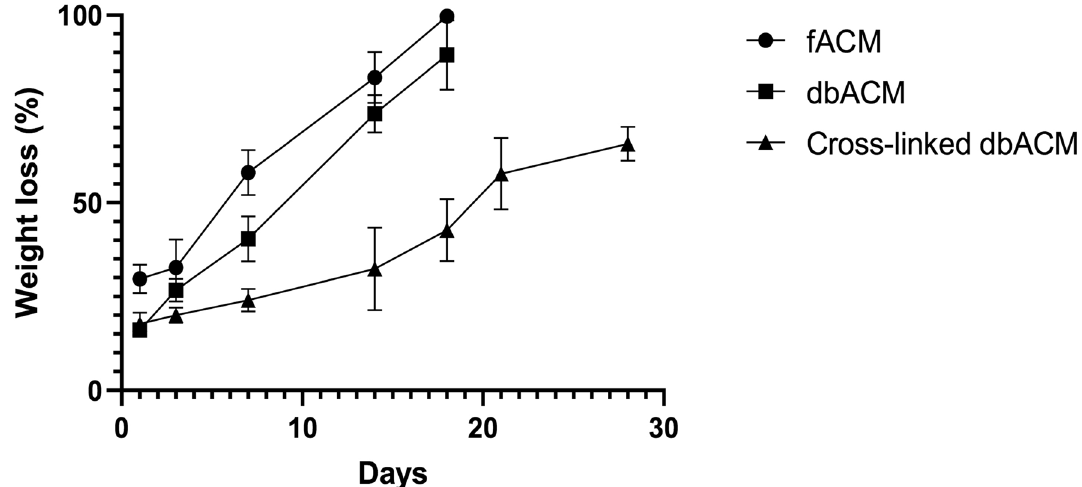
Figure 3. In vitro biodegradation test of fACM, dbACM, and cross-linked dbACM using crude collagenase with a concentration of 0.01%; values are expressed as the mean ± S.E.M (n = 3) results were analyzed using